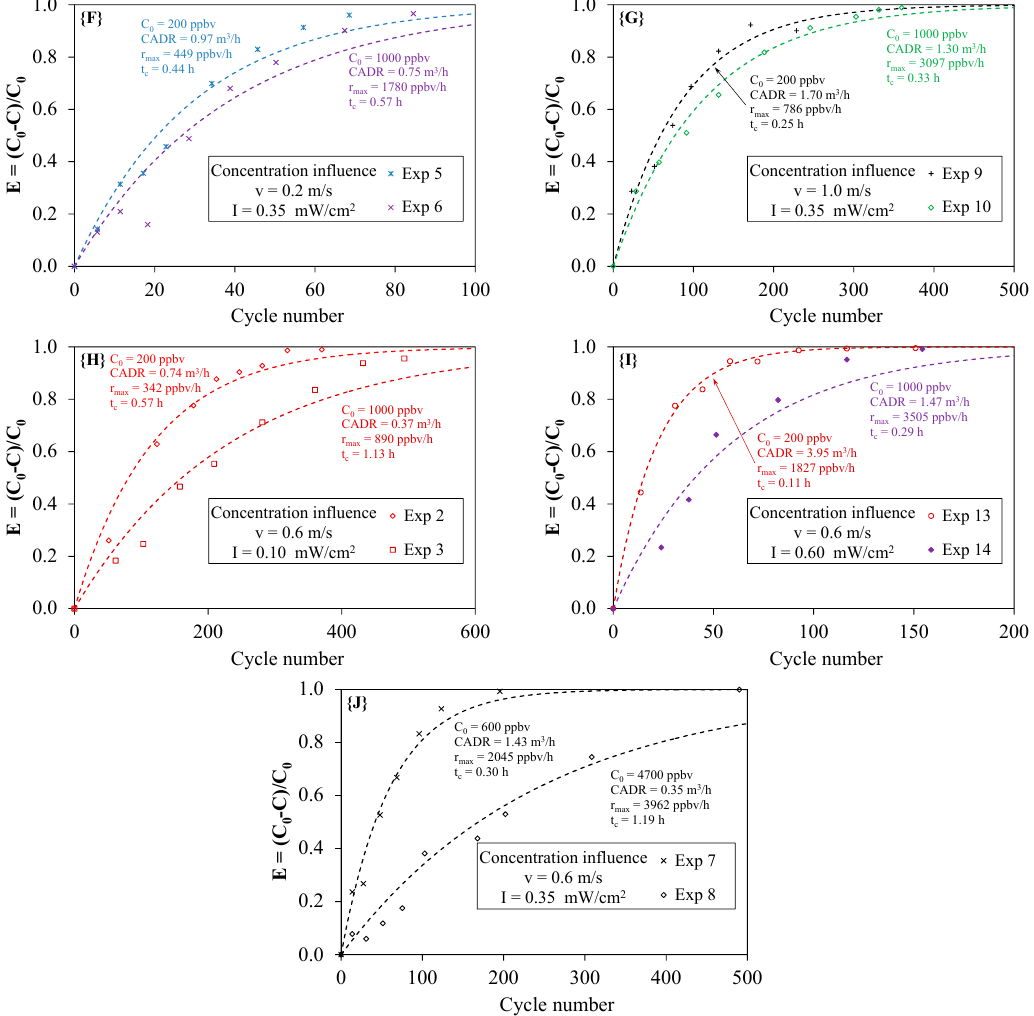
Figure 8. Effect of the initial concentration on toluene removal efficiency according to the light irradiance I and the air velocity v (cases {F} – {J} ; experimental points and model; cycle number = 1/ α ).